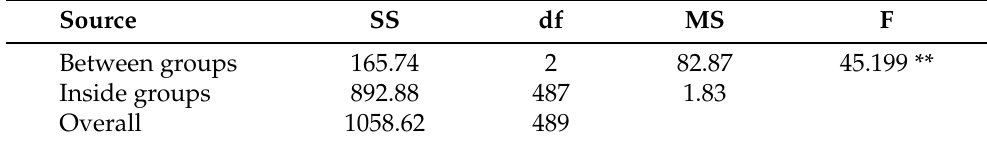
Table 4. ANOVA summary for the variable “degree of aesthetic preference” depending on the type of composition.